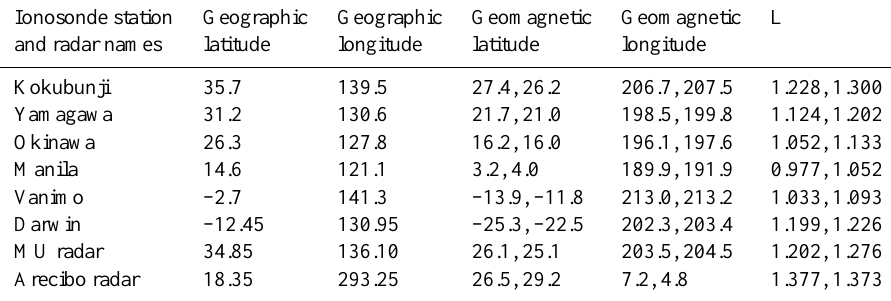
Table 1. Ionosonde station and radar names and locations. Geomagnetic latitudes and longitudes of the ionosonde stations and radars are calculated on the surface of the Earth in the eccentric (first number) and centered (second number) dipole approximations for the geomagnetic field using the parameters of these magnetic field approximations for the time period 1990. The calculated L-shell values correspond to magnetic field lines which intersect 300-km altitude over the sounders and radars, the eccentric (first number) and centered (second number) dipole approximations are